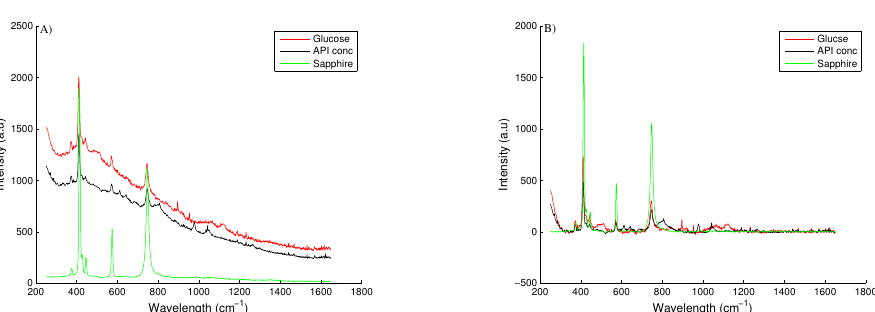
Figure A1. Raman spectra of calibration samples highlighting glucose, API and sapphire (background spectra) spectrographs, with ( A ) highlighting the raw spectra and ( B ) highlighting the baseline corrected spectra.